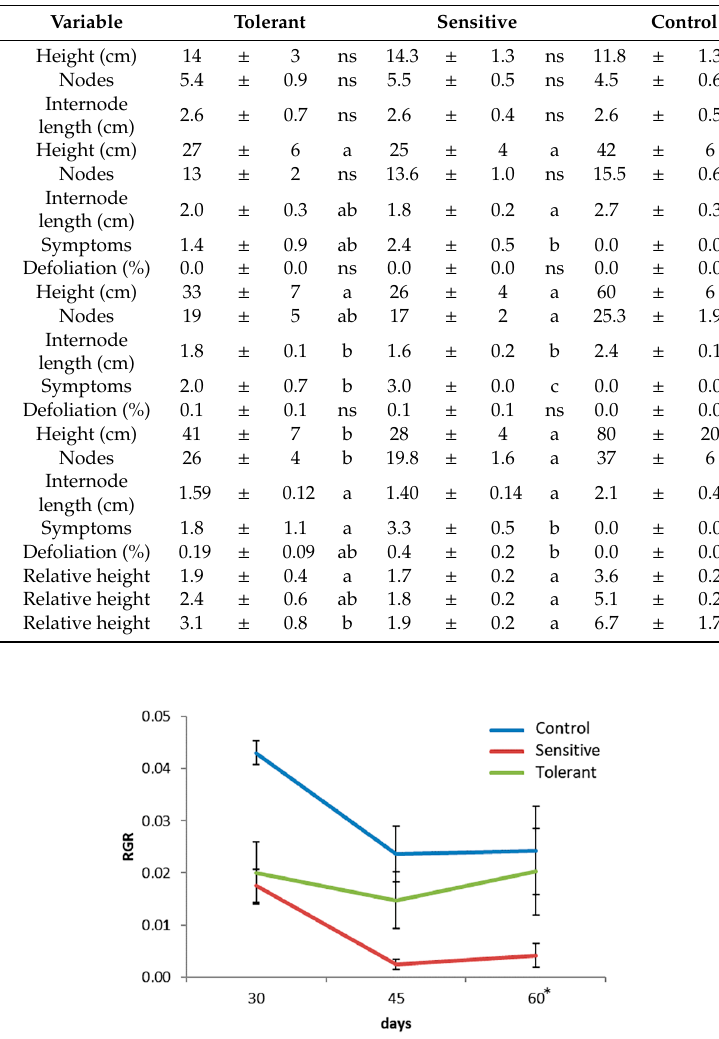
Table 1. Morphological phenotype of the plants between groups after 0, 30, 45, and 60 days. Di ff erent letters represent significant di ff erences ( p < 0.05) between groups.